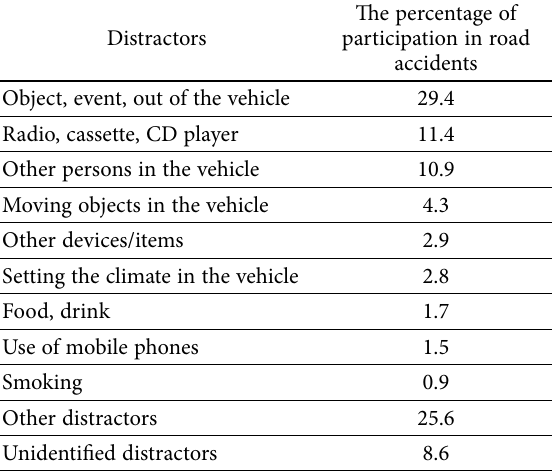
Table 1. The participation of various distractors in traffic accidents